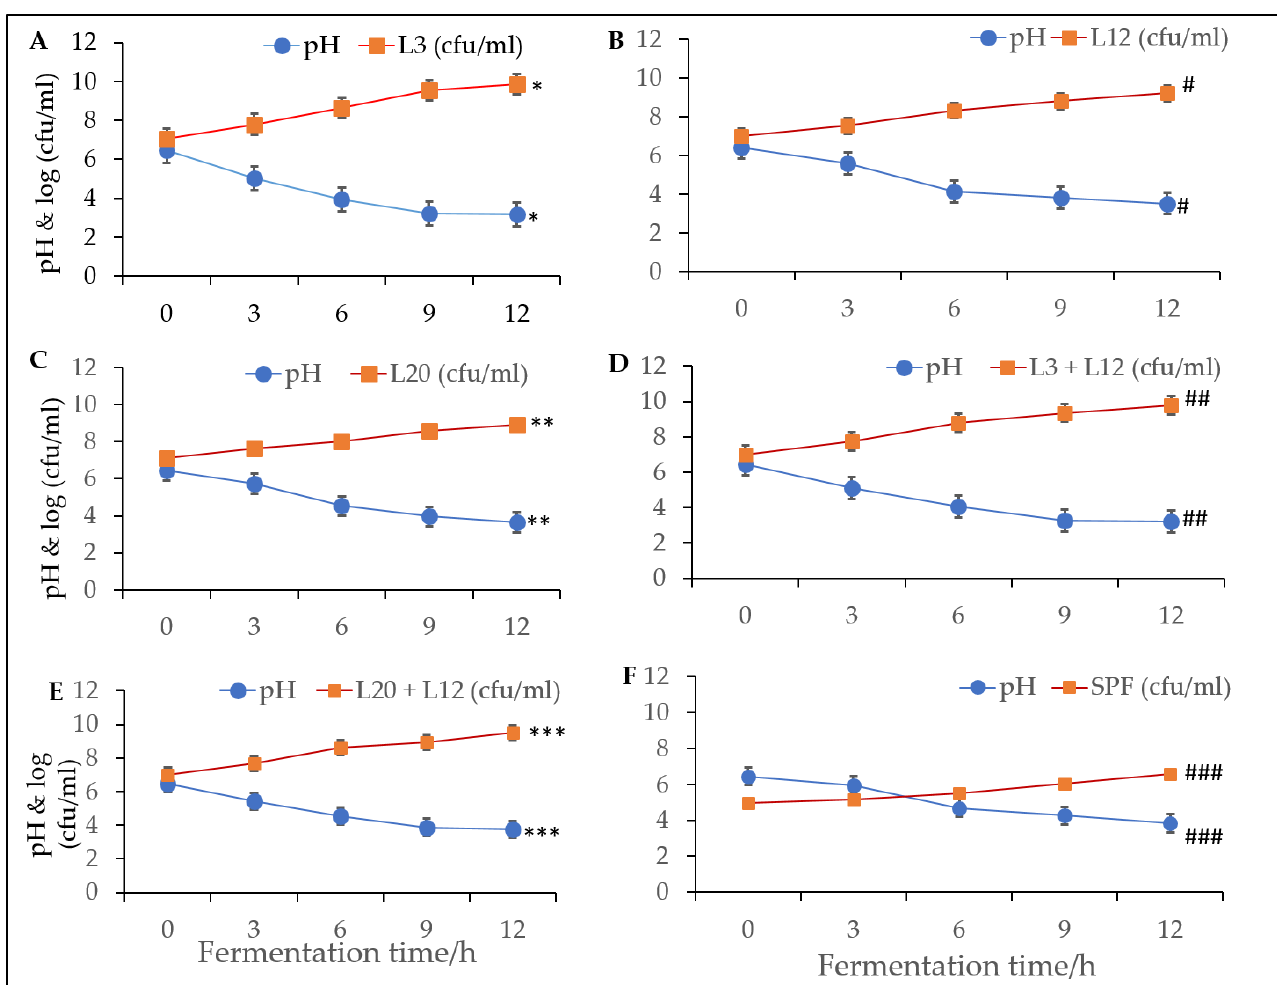
Figure 9. LAB count (log cfu/mL) and pH of yogurt produced from freeze-dried starter cultures. ( A ) Growth trajectory of Lactococcus lactis (L3) and pH under increasing fermentation time. ( B ) Growth trajectory of Lactobacillus delbrueckii (L12) and pH under increasing fermentation time. ( C ) Growth trajectory of Leuconostoc mesenterides (L20) and pH under increasing fermentation time. ( D ) Growth trajectory of Lactococcus lactis (L3) combined with Leuconostoc mesenterides (L20) and pH under increasing fermentation time. ( E ) Growth trajectory of Lactobacillus delbrueckii (L12) combined with Leuconostoc mesenterides (L20) and pH under increasing fermentation time. ( F ) Growth trajectory of Spontaneous fermentation (SPF) bacteria and pH under increasing fermentation time. Colony forming units (cfu). For ( A ), * p -value = 0.0000983. For ( B ), # p -value = 0.000098. For ( C ), ** p -value = 0.000208. For ( D ), ## p -value = 0.000099. For ( E ), *** p -value = 0.0001052. For ( F ), ### p -value = 0.042738.